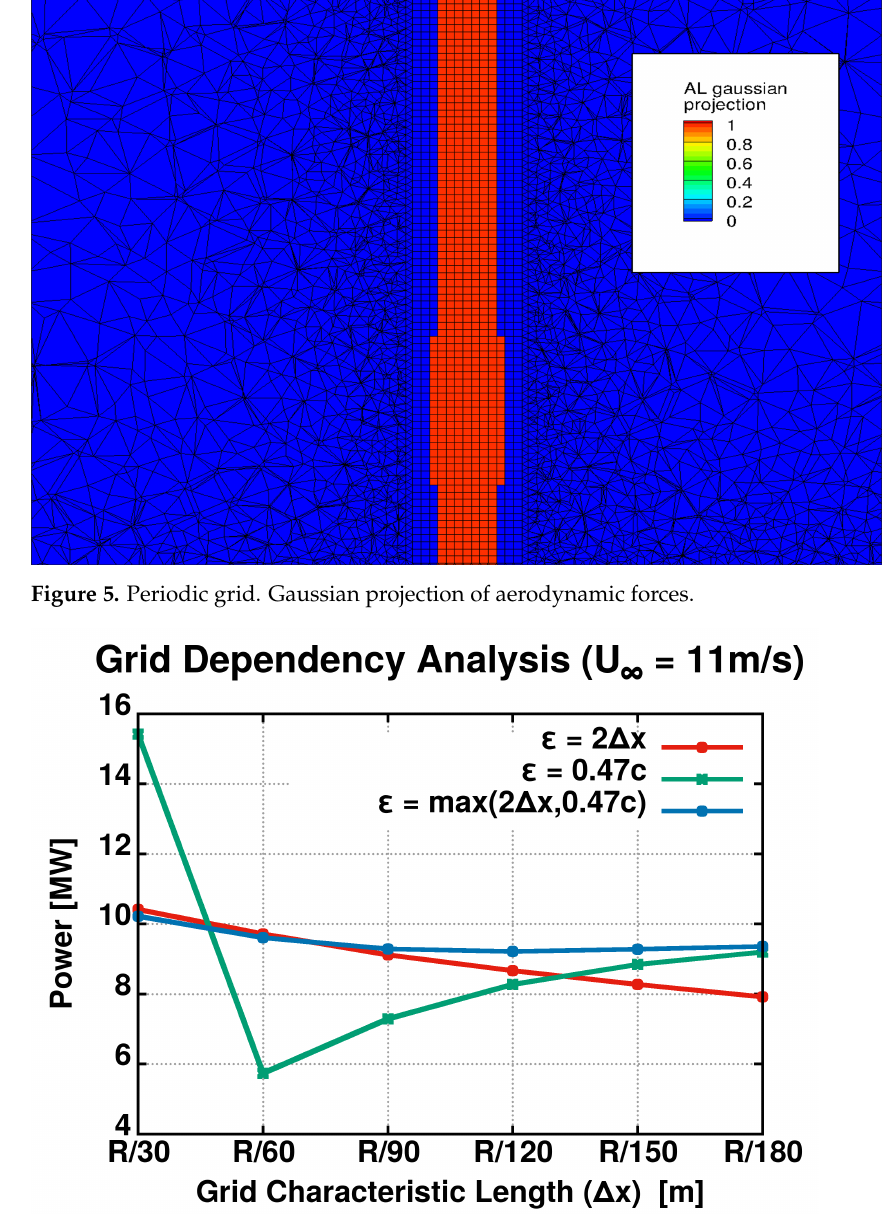
Figure 6. Grid dependency analysis. Power [MW] vs grid characteristic length ∆ x